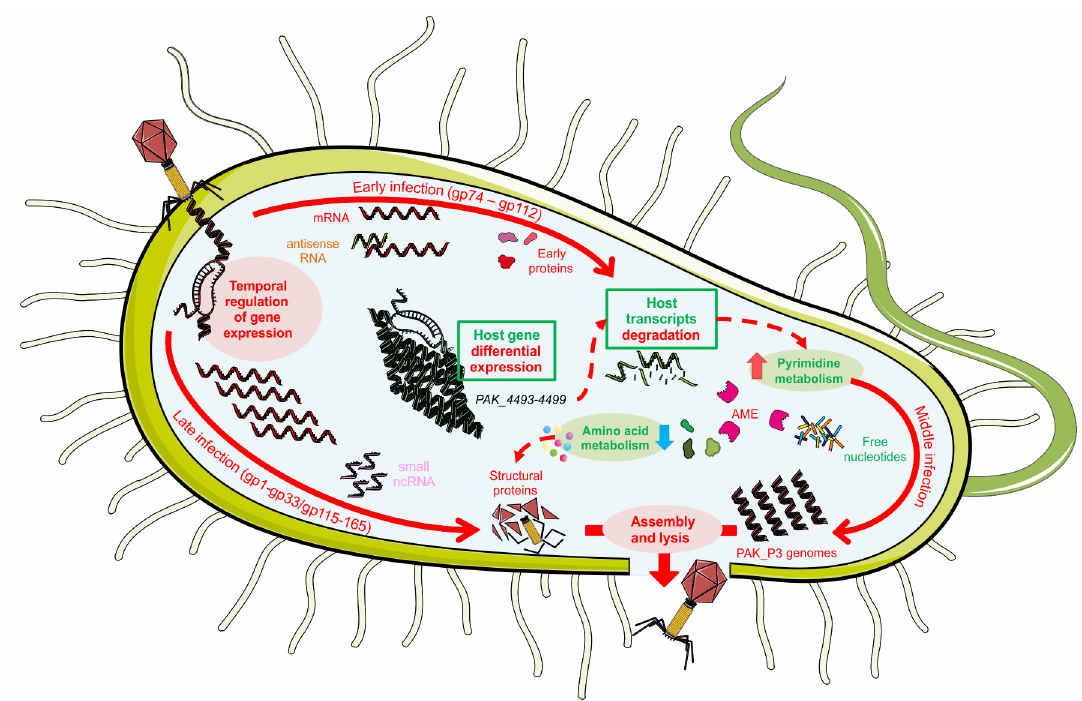
Fig 8. Molecular details of PAK_P3 infection cycle of P . aeruginosa strain PAK. Red and green colors correspond to phage and host elements respectively. A description of the figure is given in the text (see Discussion). Full arrows depict the three temporal stages of PAK_P3 infection cycle. Dashed arrows represent relations between metabolic pathways highlighted by our “ -omics ” analyses. AME = Auxiliary Metabolic Enzymes.